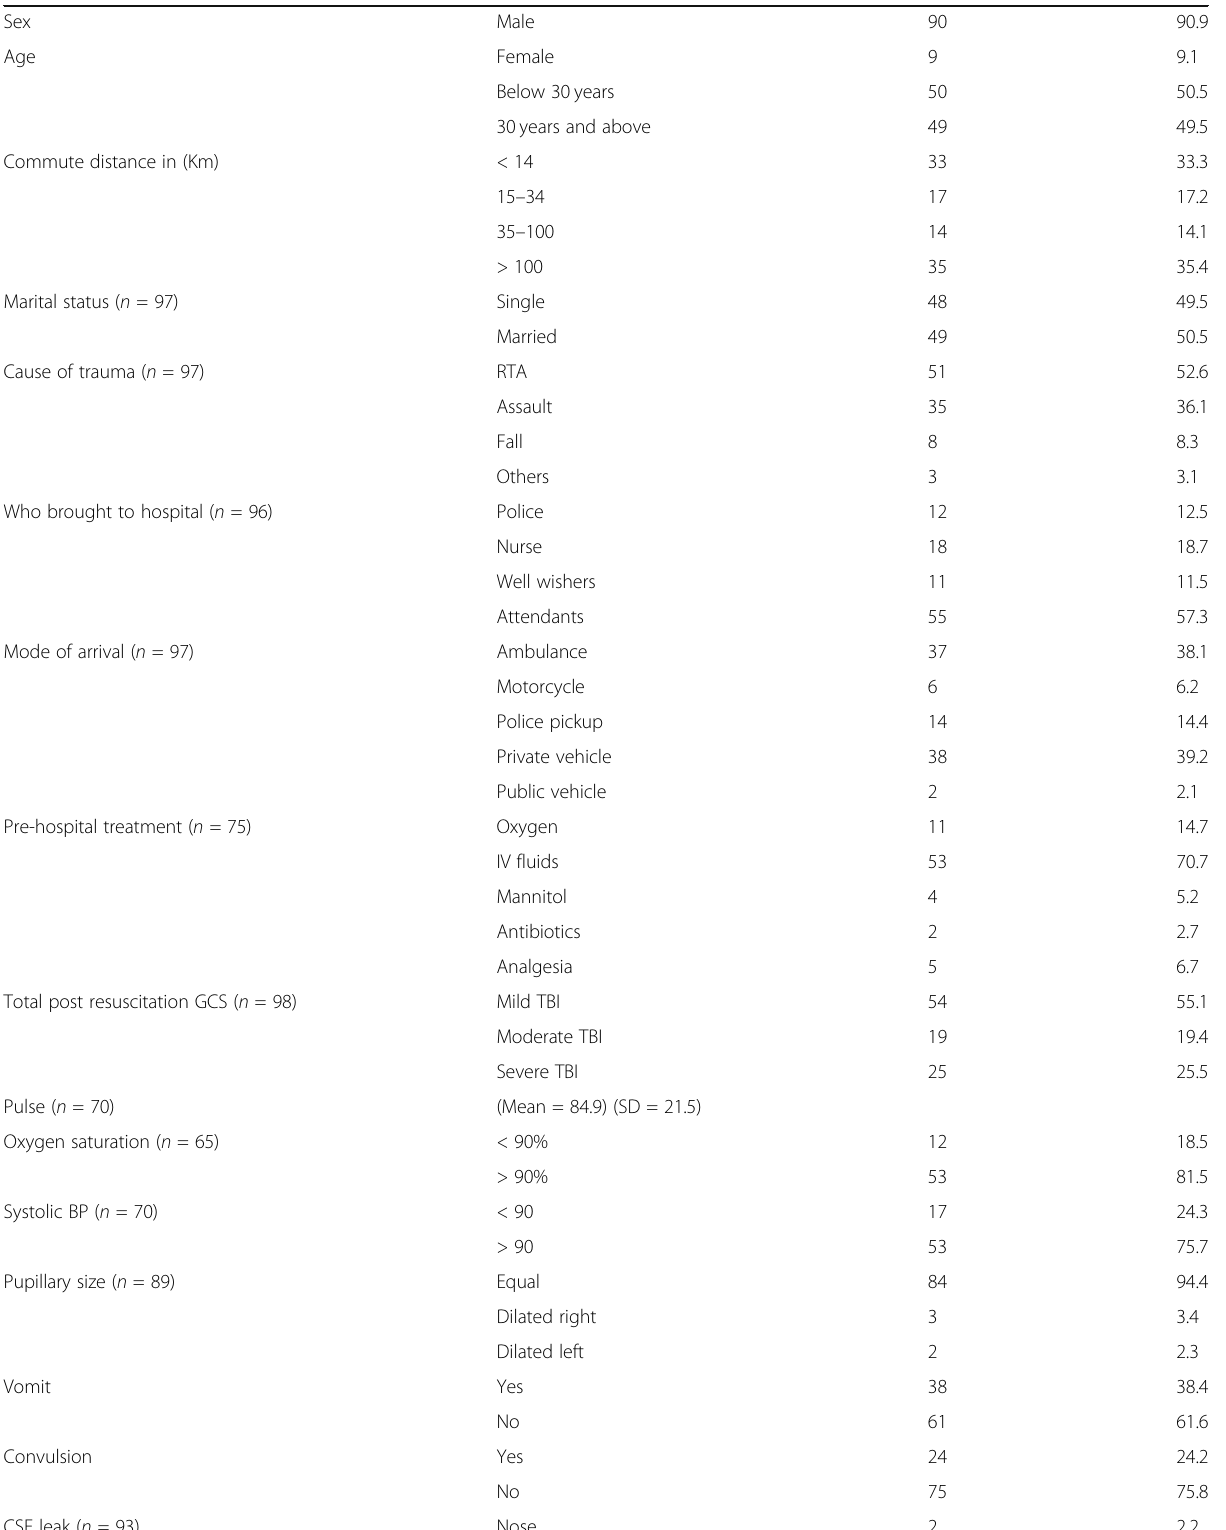
Table 1 Baseline demographic and clinical characteristics of patients with extra-axial haematoma at Mulago NRH